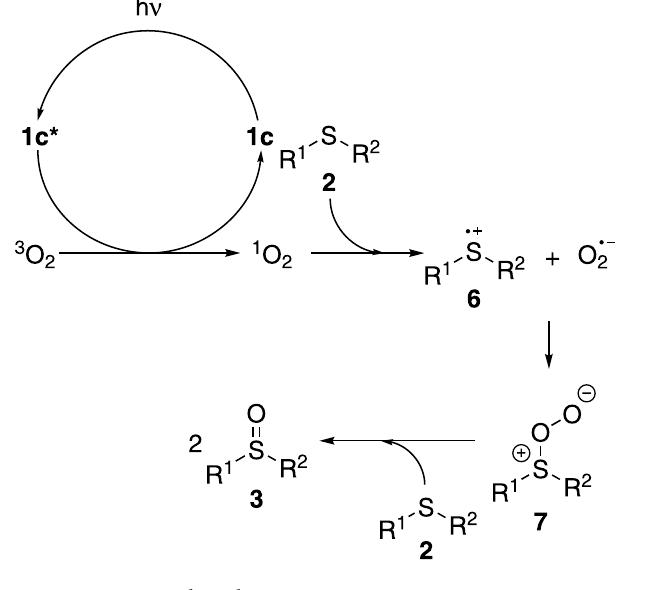
Figure 5. Proposed